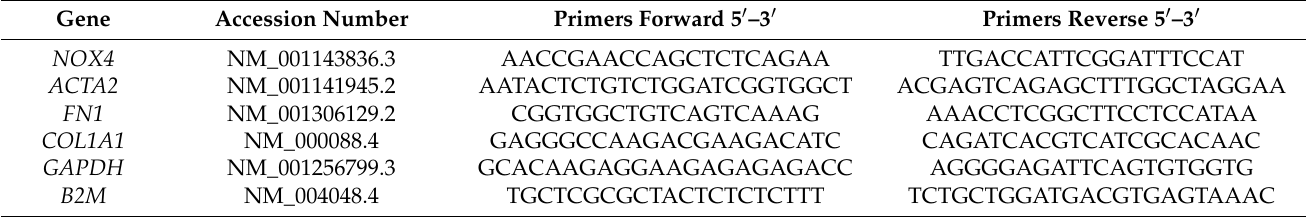
Table 1. RT-qPCR primers used in the